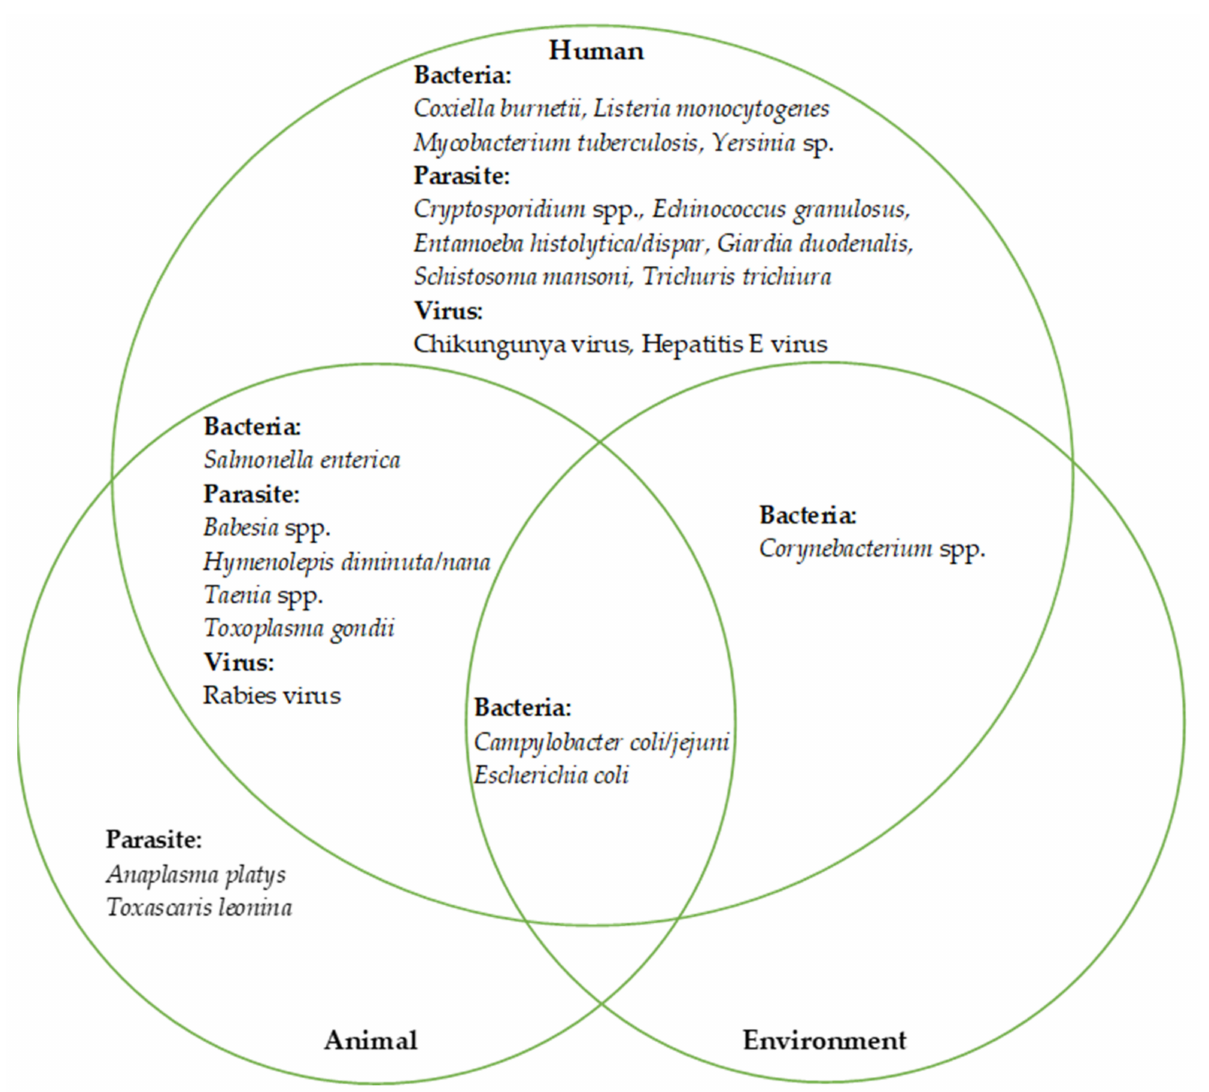
Figure 4. Rodent-related zoonotic pathogens identified at the human–animal–environmental interface in